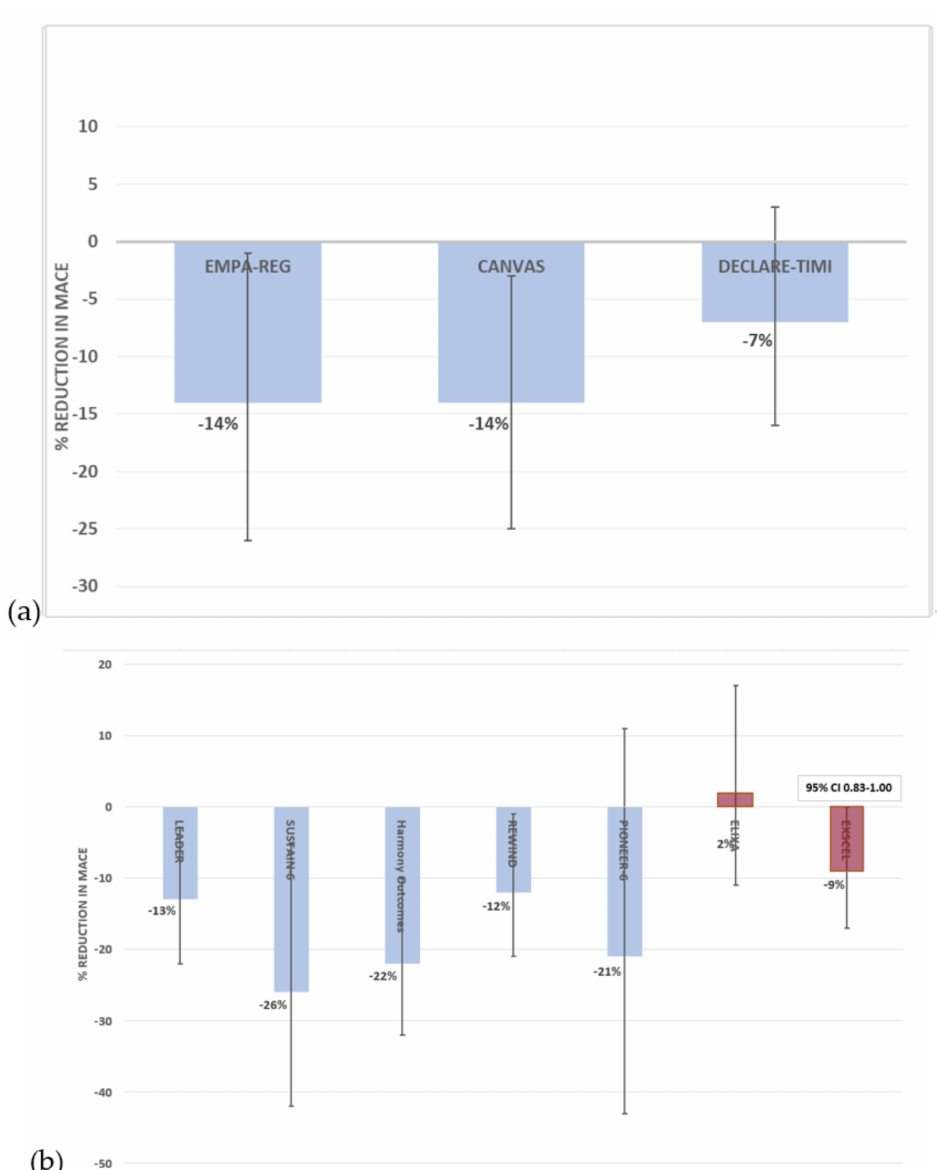
Figure 2. Summary of e ff ects on major adverse cardiovascular outcomes including death from cardiovascular causes, non-fatal myocardial infarction and non-fatal stroke for ( a ) Sodium–glucose cotransporter 2 (SGLT2) inhibitors and ( b ) Glucagon-like peptide 1 receptor agonists (GLP1-RA) in patients with type 2 diabetes (blue = human GLP1-based, red = exendin-4 based). Error bars represent 95% confidence